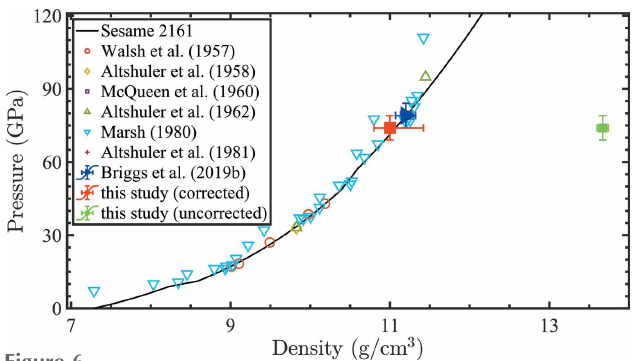
Figure 6 Tin densities on the Hugoniot derived from gas gun experiments (Walsh et al. , 1957; Altshuler et al. , 1958; McQueen & Marsh, 1960; Altshuler et al. , 1962, 1981; Marsh, 1980) with density derived from the current study plotted with the red glyph. The SESAME 2161 pressure–density table is shown with the solid black line (Greeff et al. , 2005). The density without accounting for the pink beam is shown by the green glyph. It should be noted that the reported liquid density using dynamic compression experiments in Briggs et al. (2019 a ) (blue glyph) was estimated by pinning the VISAR pressure on the Sesame 2161 hugoniot. Quantitative estimate was not possible using the collected diffraction